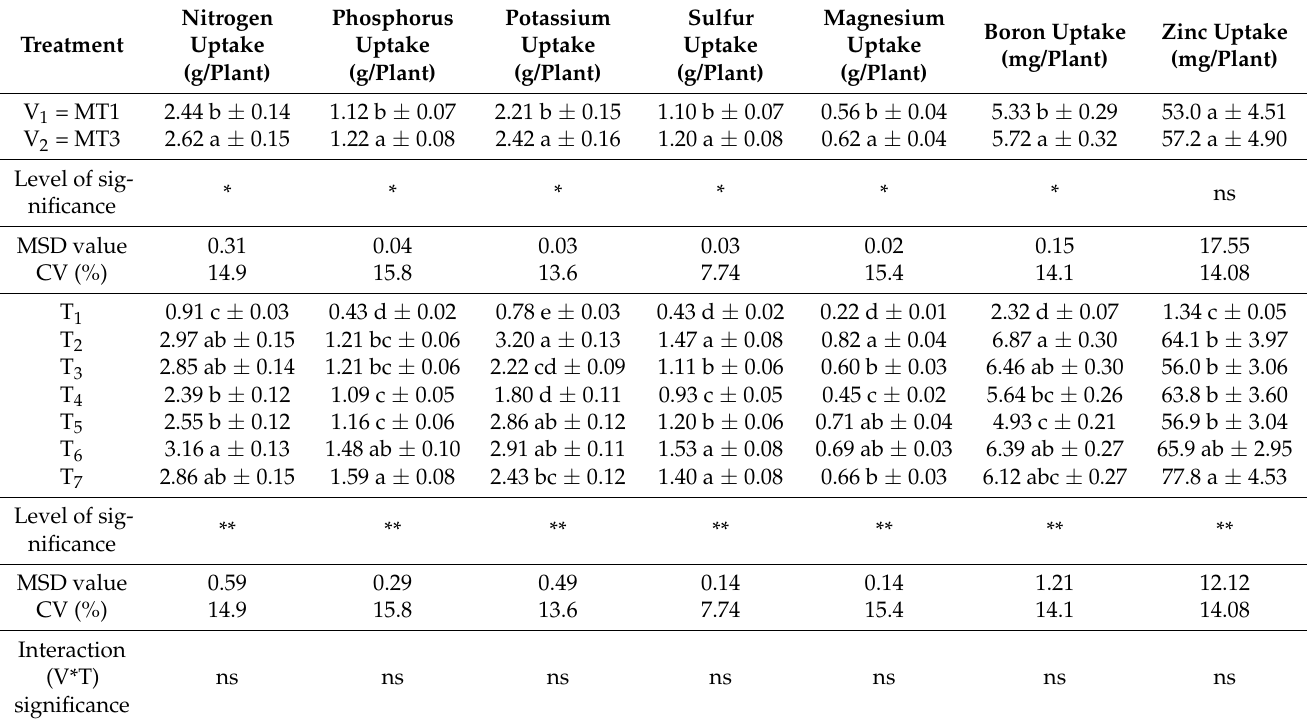
Table 11. Effect of zinc fertilizer and zinc oxide nanoparticles on nitrogen, phosphorus, potassium, sulfur, boron, and zinc uptake by leaves of two selected tomatoes